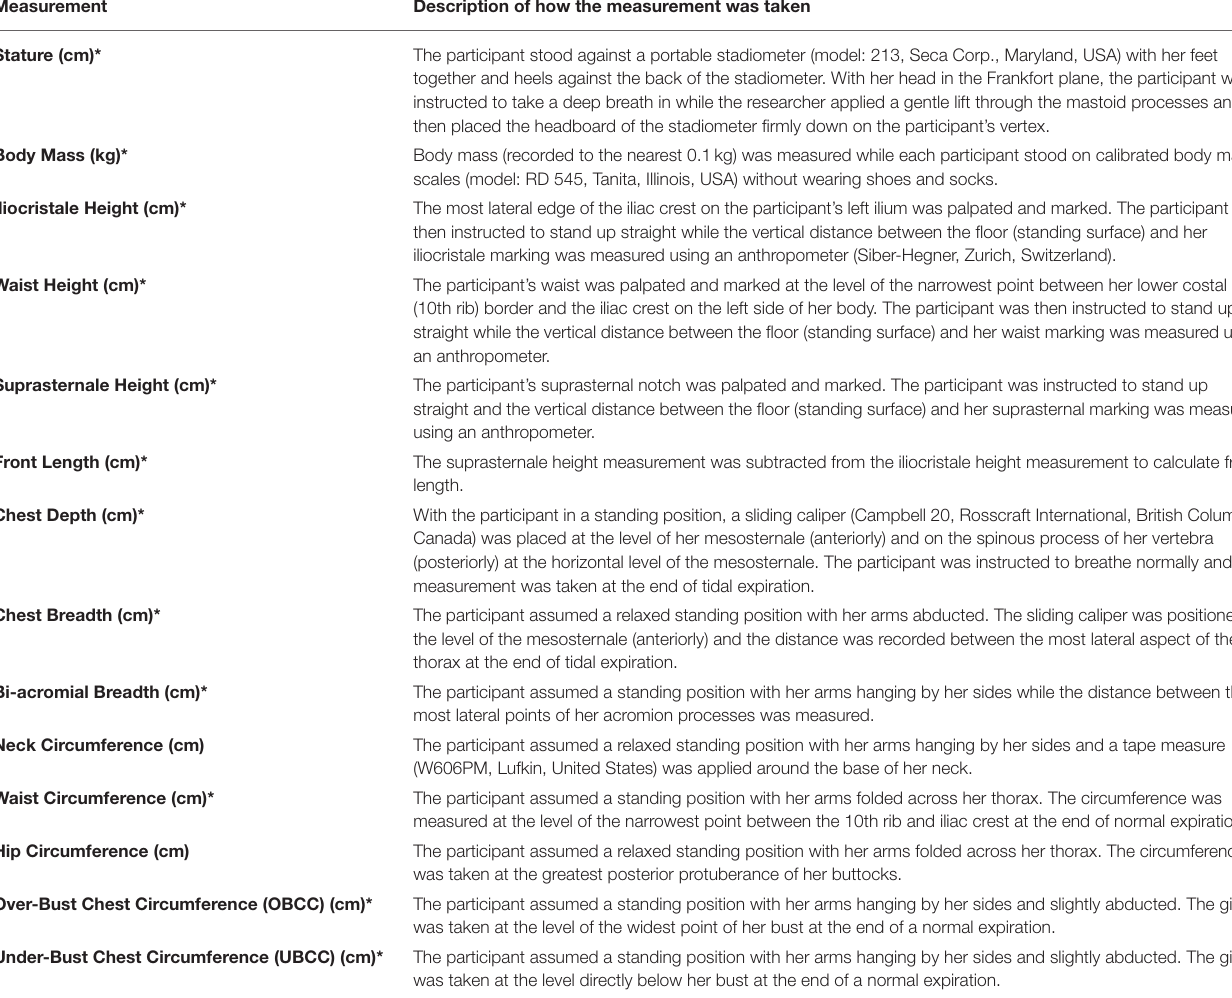
TABLE 2 | The anthropometric measurements collected during the current study, including a brief description of the protocol associated with each measurement. Measurement Description of how the measurement was